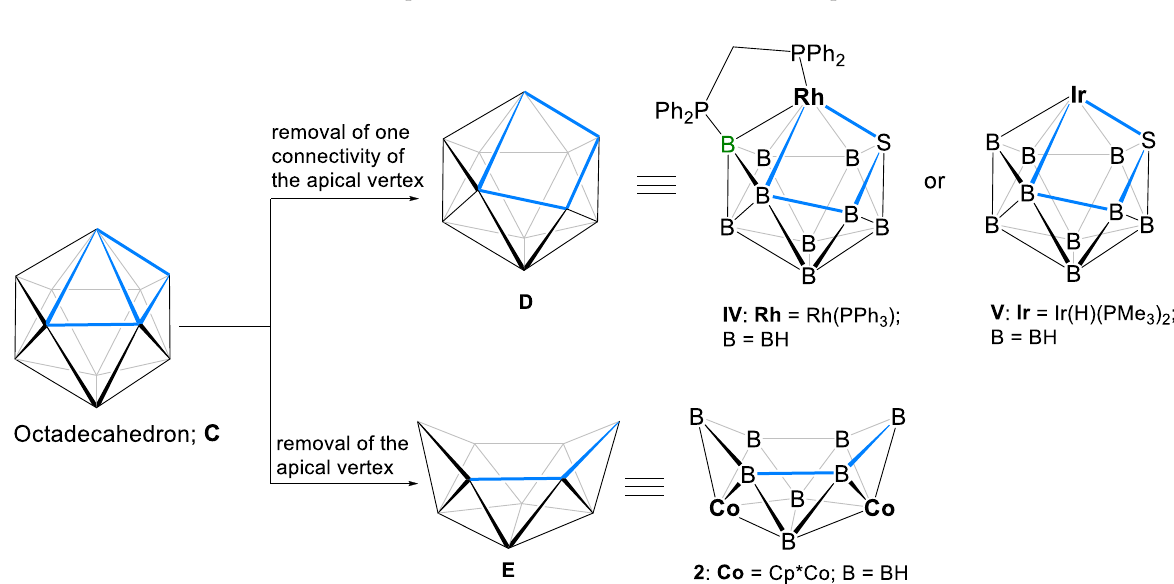
Figure 3. Schematic representation of stepwise generation of the 11-vertex isonido ( D ) and 10-vertex nido ( E ) cluster frameworks from an octadecahedron ( C ) and their examples.